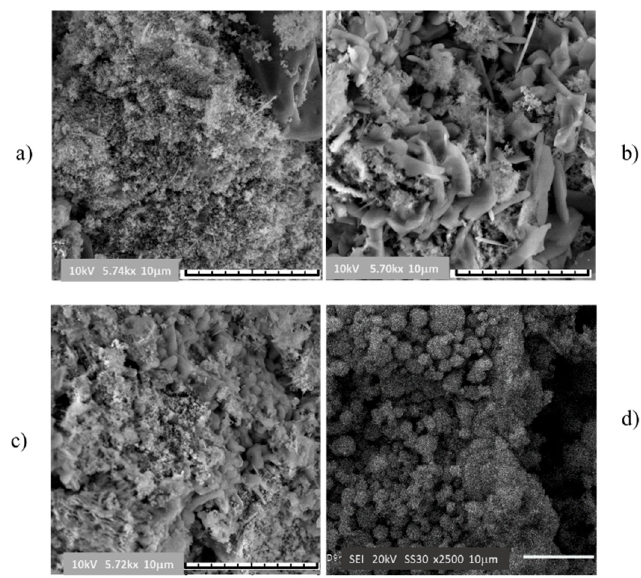
Figure 3. SEM images of the ZnOS samples obtained at different pH values. ( a ) ZnOS-9, ( b ) ZnOS-10, ( c ) ZnOS-11, ( d ) ZnO.